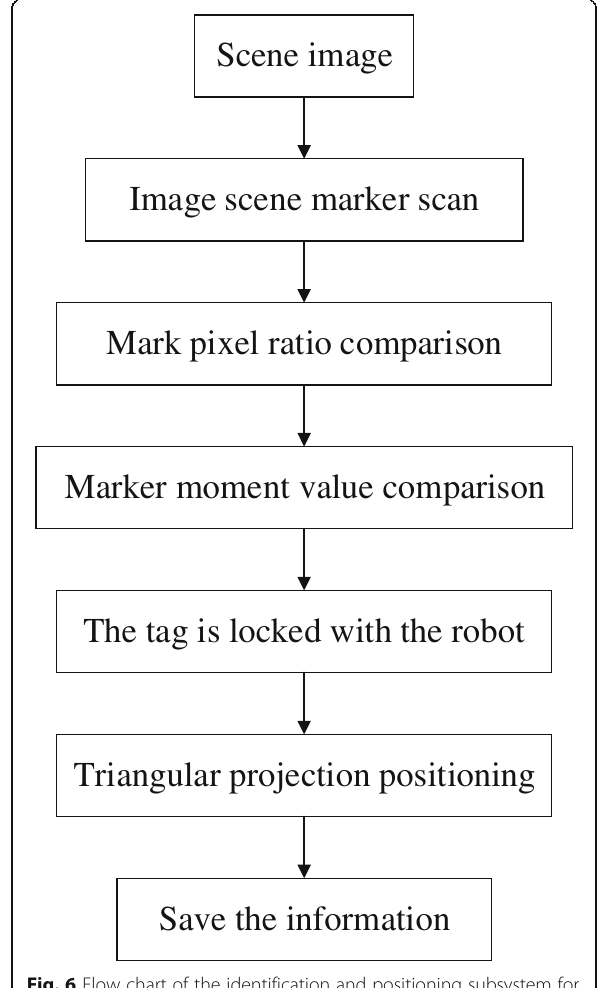
Fig. 6 Flow chart of the identification and positioning subsystem